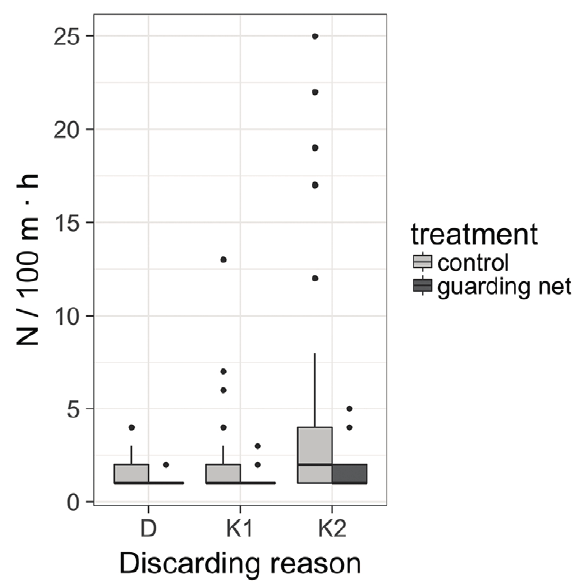
Fig. 4. – Abundance of unwanted catches in the guarding net con- figuration. (N/100 m h per species) compared with the control net. Discarding reasons: (D) undersize individuals falling under the Landings Obligation (Art. 15 of EU Reg. 1380/2013); (K1) damaged individuals of otherwise commercial species; (K2) non-commercial benthic